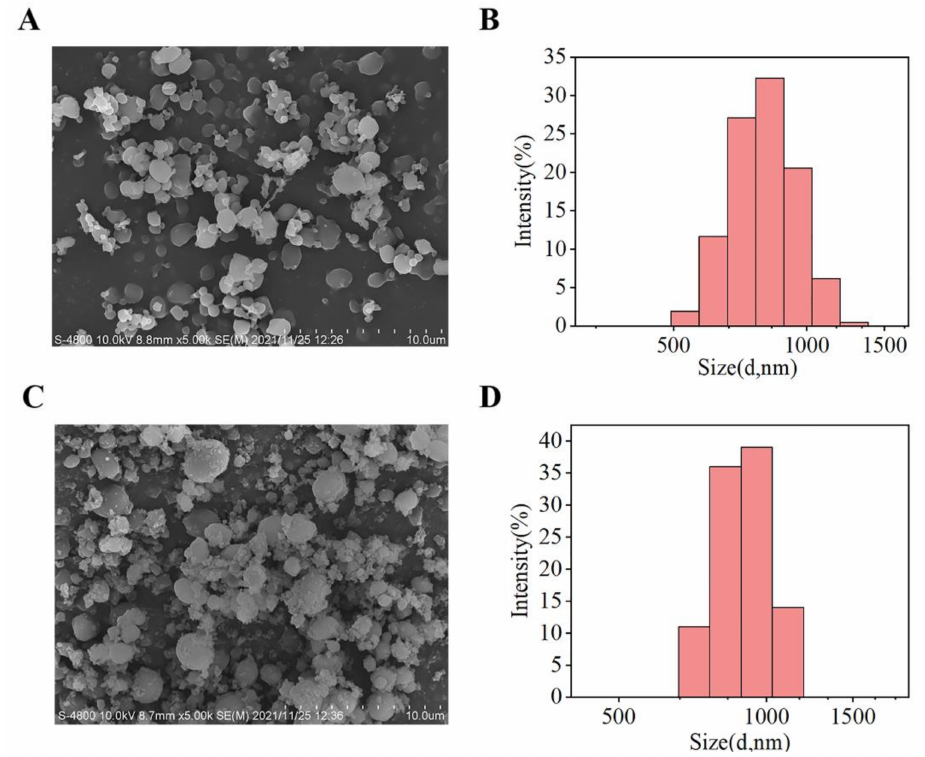
Figure 2. Morphology character of samples. ( A ) SEM images of PLLA/CM microparticles. ( B ) Size distribution of PLLA/CM microparticles. ( C ) SEM images of PDA-PLLA/CM microparticles. ( D ) Size distribution of PDA-PLLA/CM